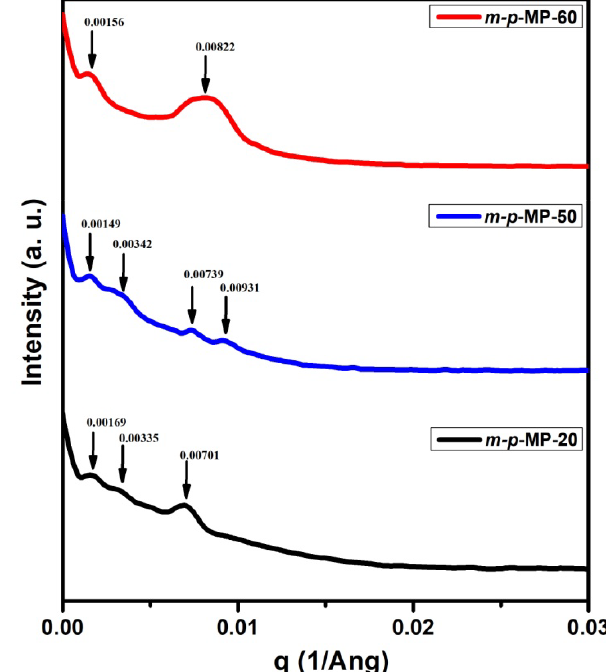
Figure 3. Small angle X-ray scattering (SAXS) profiles of the m-p -MP-20, m-p -MP-50, and m-p -MP-60 copolymer membranes.